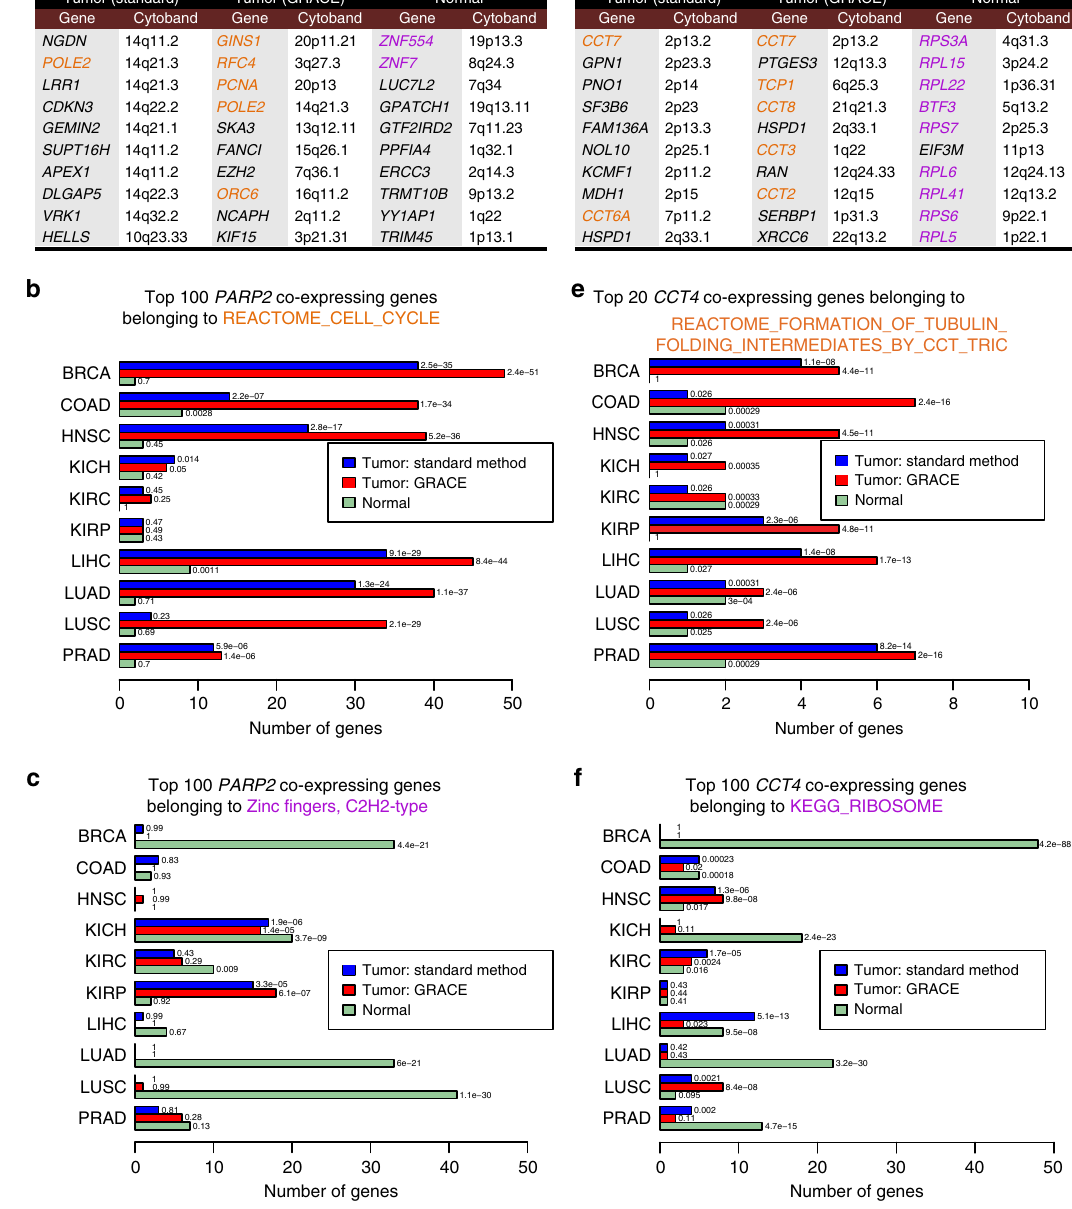
Fig. 3 Examples of co-expressing genes differing in tumor vs. normal tissues. a Top 10 PARP2 co-expressing genes from tumor (by standard method or GRACE) or normal tissue samples. Top PARP2 co-expressing genes by standard method in tumors are dominated by genes from 14q, whereas top PARP2 co-expressing